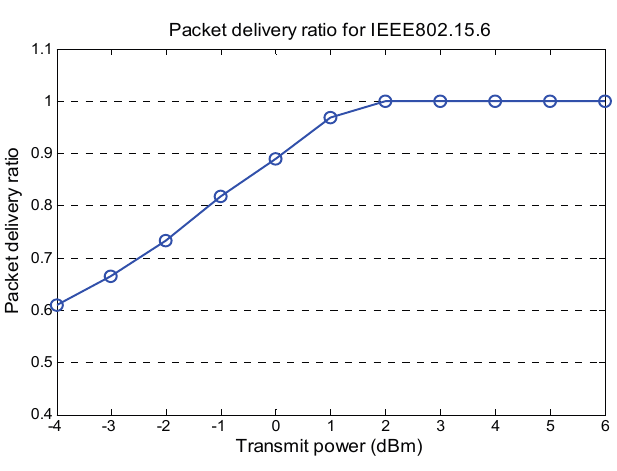
Figure 7. Packet delivery ratio for IEEE